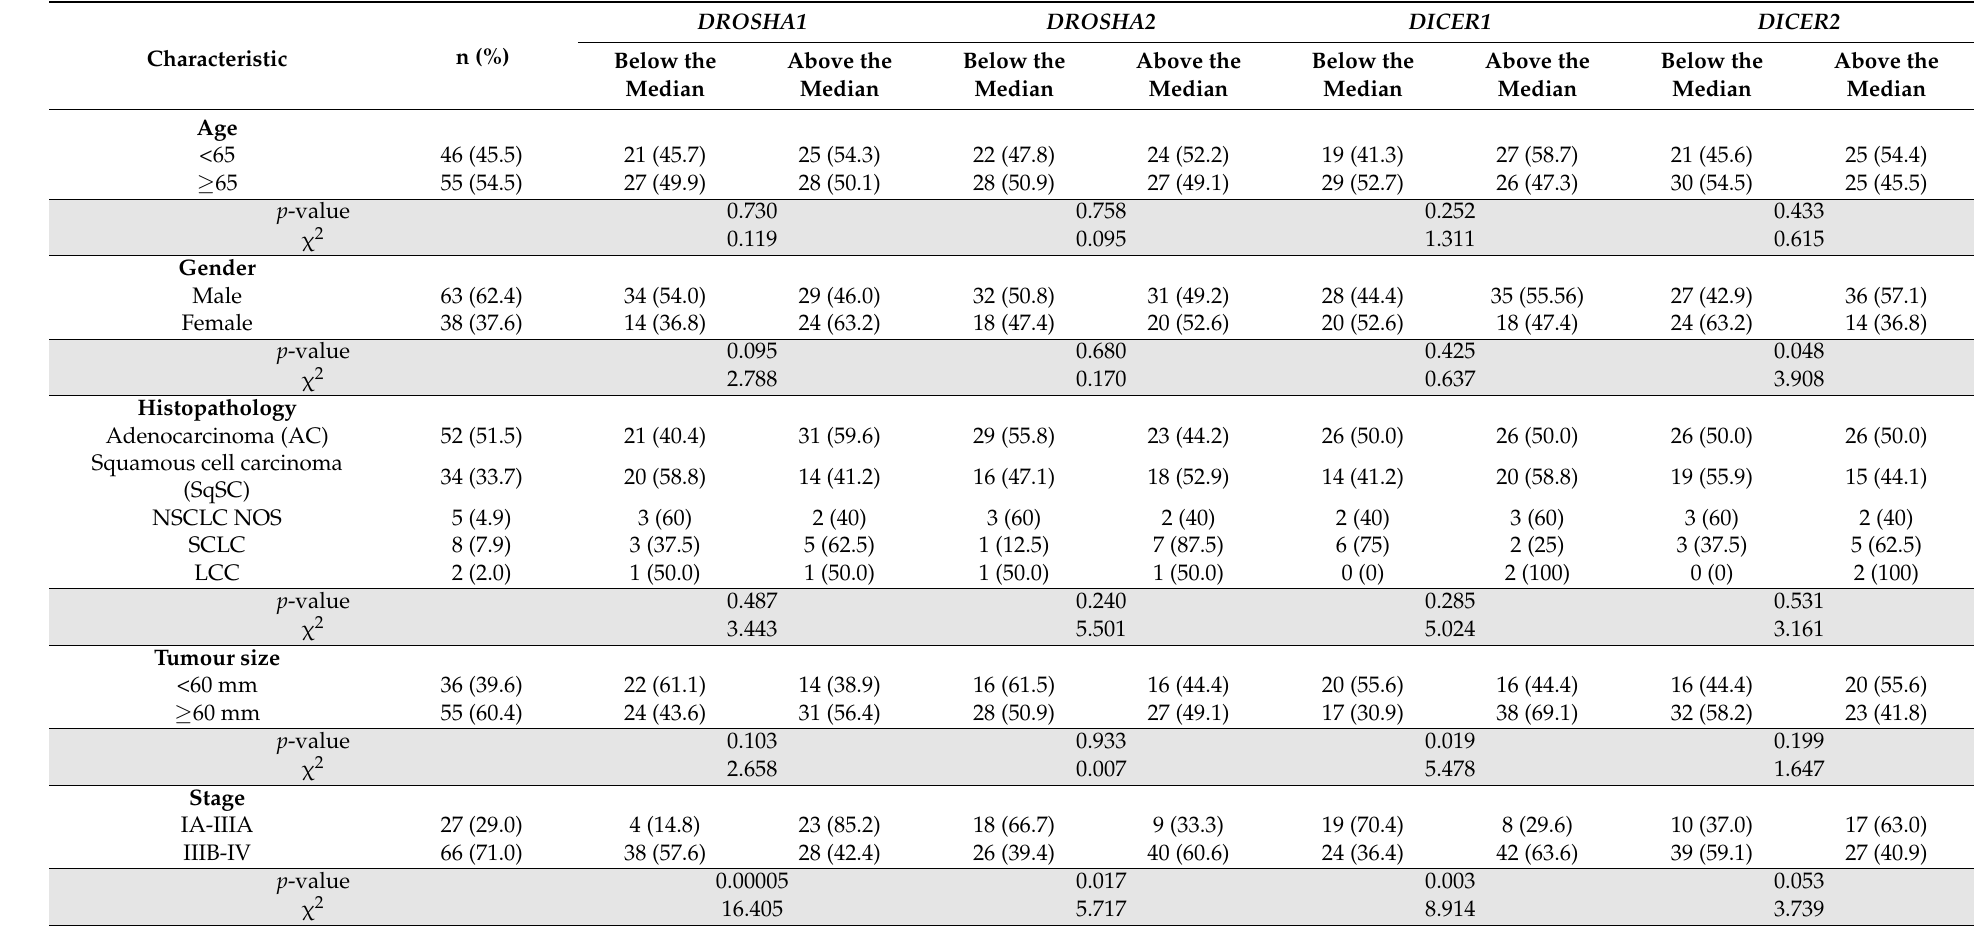
Table 1. Characteristics of the studied